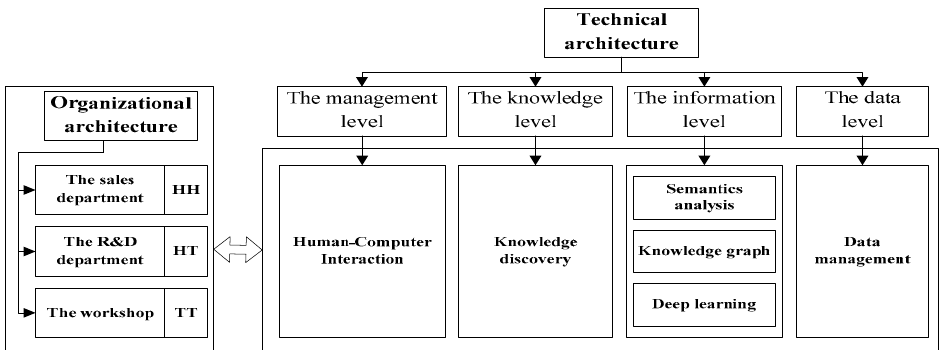
Figure 5. The overall architecture of the MC–SIOT